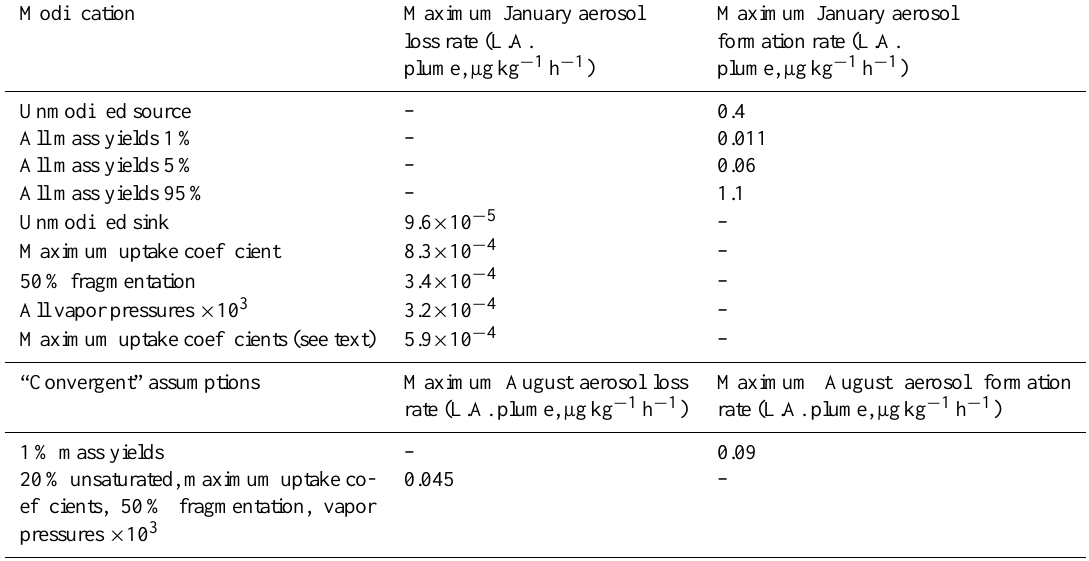
Table 3. Results of model sensitivity